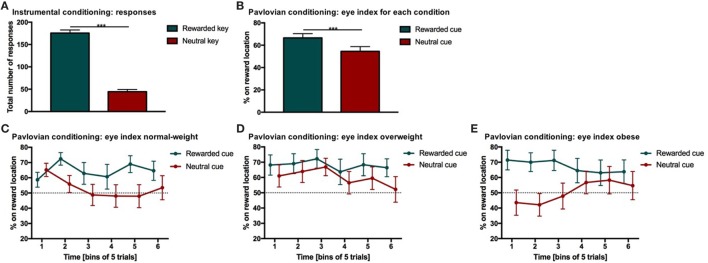
Results from instrumental and Pavlovian conditioning. Error bars indicate SEM. The rewarded key/condition is depicted in green and the neutral key/condition in red. (A) Total number of responses for each condition during instrumental conditioning. Participants chose the rewarded response significantly more often than the neutral response (***p
RESPONSE TYPE < 0.001, d = 2.9). (B) Percentage of time on reward location during Pavlovian conditioning. The eye index indicates if more time was spent on the reward location or on the cue location of the screen. The eye index was analyzed in bins of five trials for the rewarded and neutral condition and each weight category. The percentage of time on the reward location differed significantly between rewarded and neutral trials (***pCONDITION < 0.001, d = 0.41). (C–E) Percentage of time on reward location during Pavlovian conditioning for each weight category. The eye index differed significantly between conditions over time and weight categories (normal-weight N = 20, overweight N = 17, obese N = 17, pCONDITION*TIME*WEIGHT CATEGORY < 0.05).